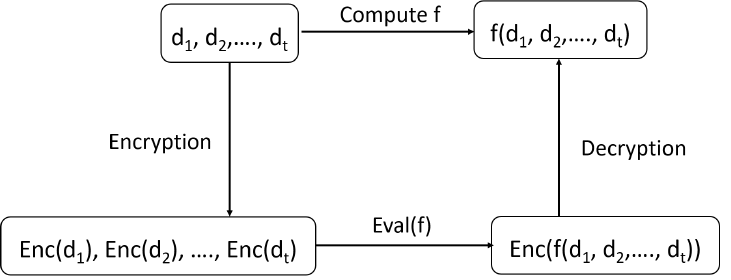
Figure 4. Homomorphic Encryption